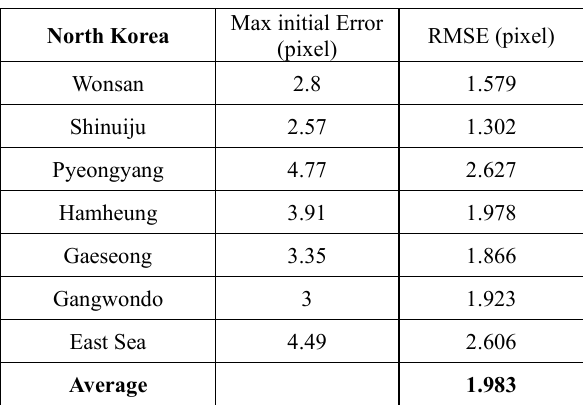
Table 7. Check point geolocation accuracy of precise sensor model (North